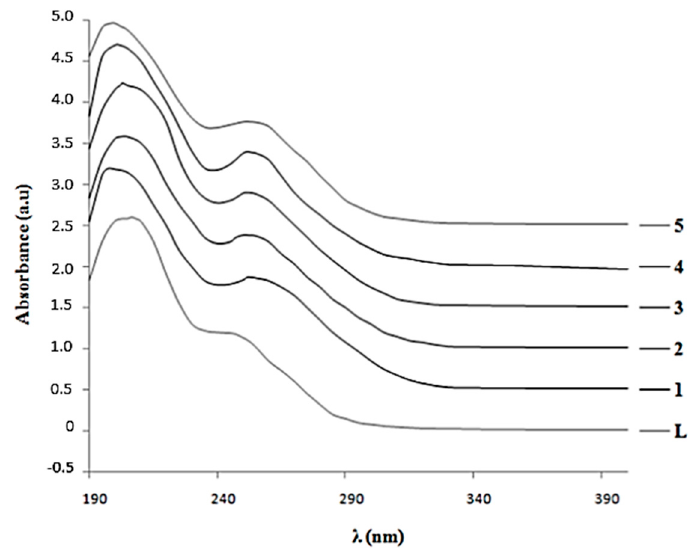
Figure 8. The UV spectra of ligand L and complexes 1–5.